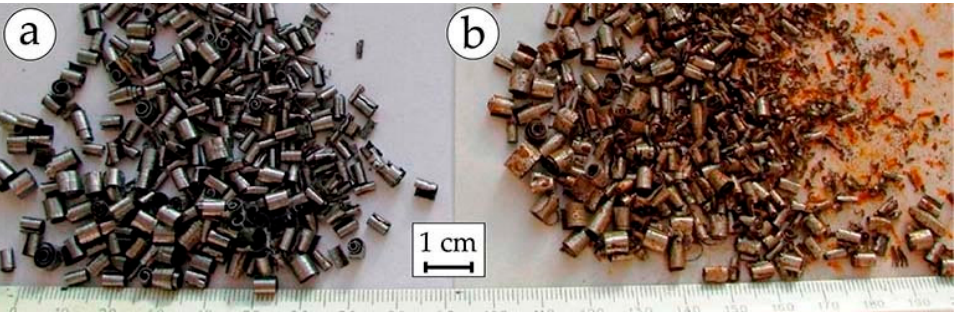
Figure 4. View of steel chips following turning in LCL s ( a ) and water ( b ) after 100 h. The small angle of wettability of the LCLs with the steel surface ensured better pen- etration into the processing zone and verified the protective effect of 38KHN3MFA steel.